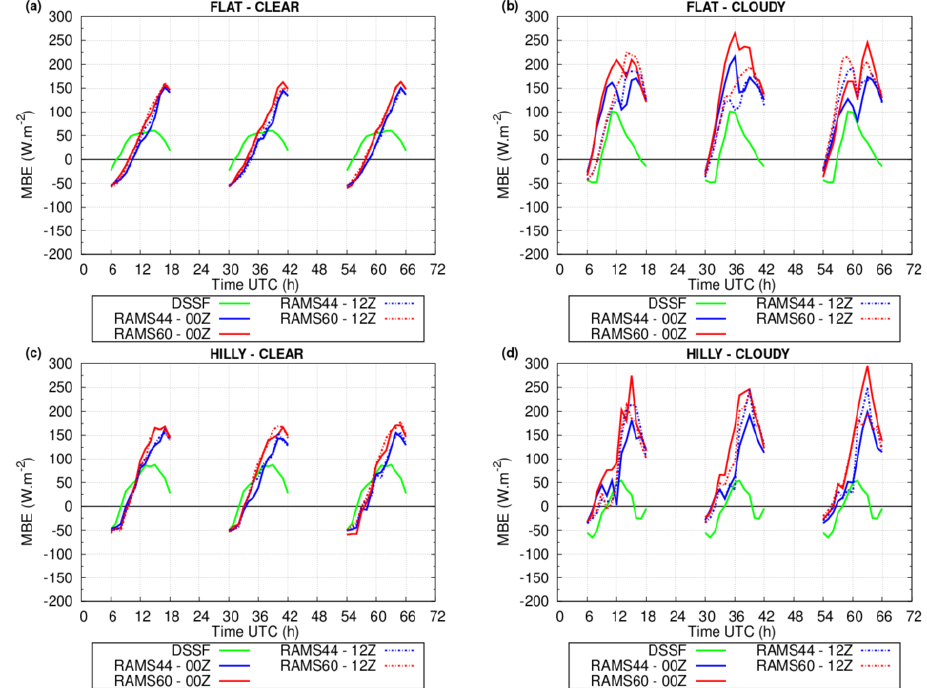
Figure 6. MBE (W·m − 2 ) hourly solar radiation cycle from dawn to dusk, considering the complete forecast horizon (three days of simulation), during the summer 2011, segmented based on terrain classes (flat and hilly) and atmospheric condition (clear and cloudy sky): flat-clear ( a ); flat-cloudy ( b ); hilly-clear ( c ) and hilly-cloudy ( d ).